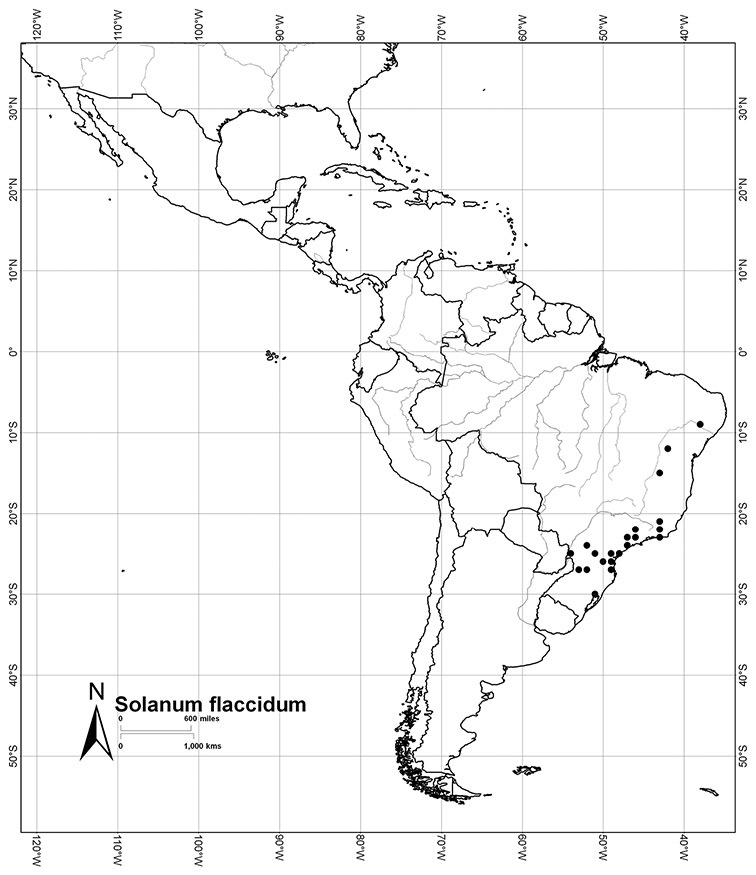
Distribution of Solanum flaccidum Vell.